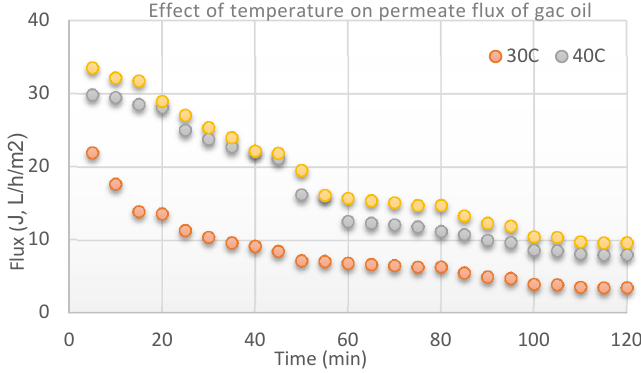
Table 7. Effect of temperature on retention coefficient of TCC in retentate.